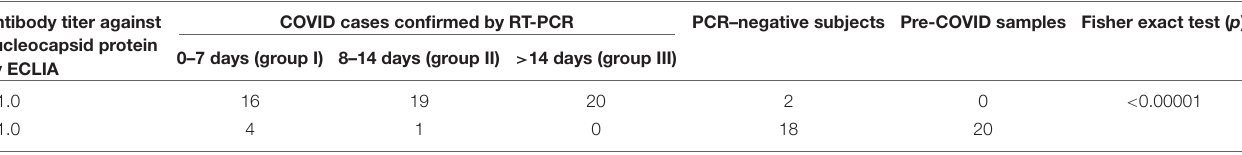
TABLE 2 | Distribution of total antibody against nucleocapsid protein of SARS-CoV-2 test results at 0–7, 8–14, and > 14 days of RT-PCR–positive confirmed COVID-19 cases, PCR-negative subjects, and pre–COVID-19 controls. Antibody titer against COVID cases confirmed by nucleocapsid protein by ECLIA